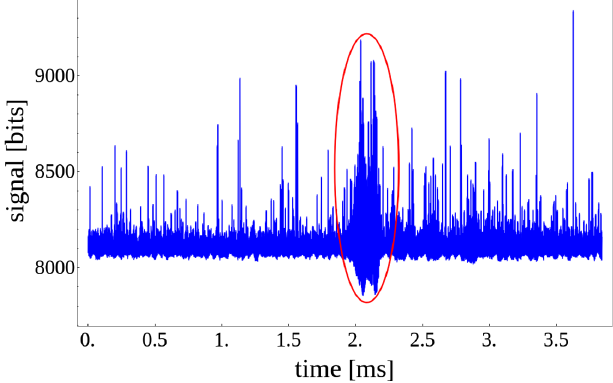
colliding.FIG. 8. Raw signal of a UFO recording by a dBLM downstream of the collimators. The UFO is